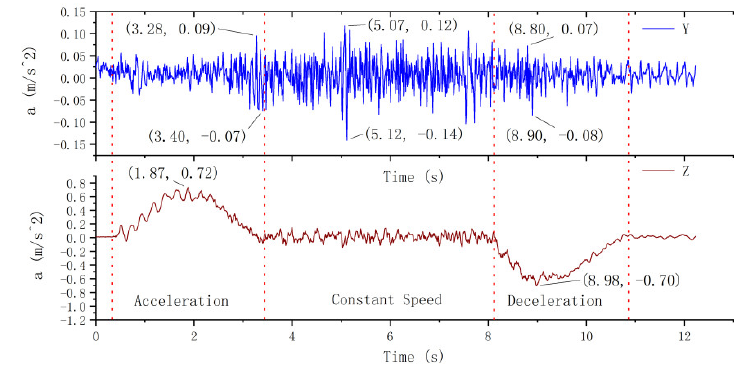
Figure 7. Vibration of the car frame.